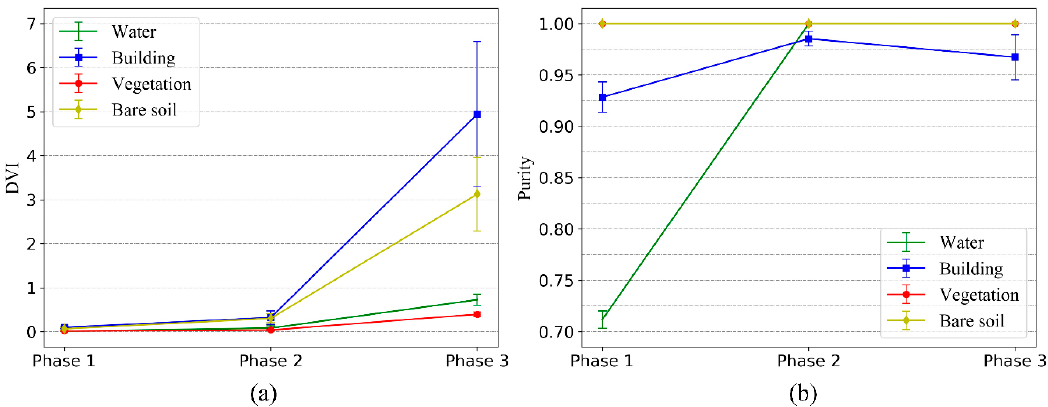
Figure 5. The mean and standard deviation curves of each phase. ( a ) The DVI of each phase. ( b ) The purity of each phase.